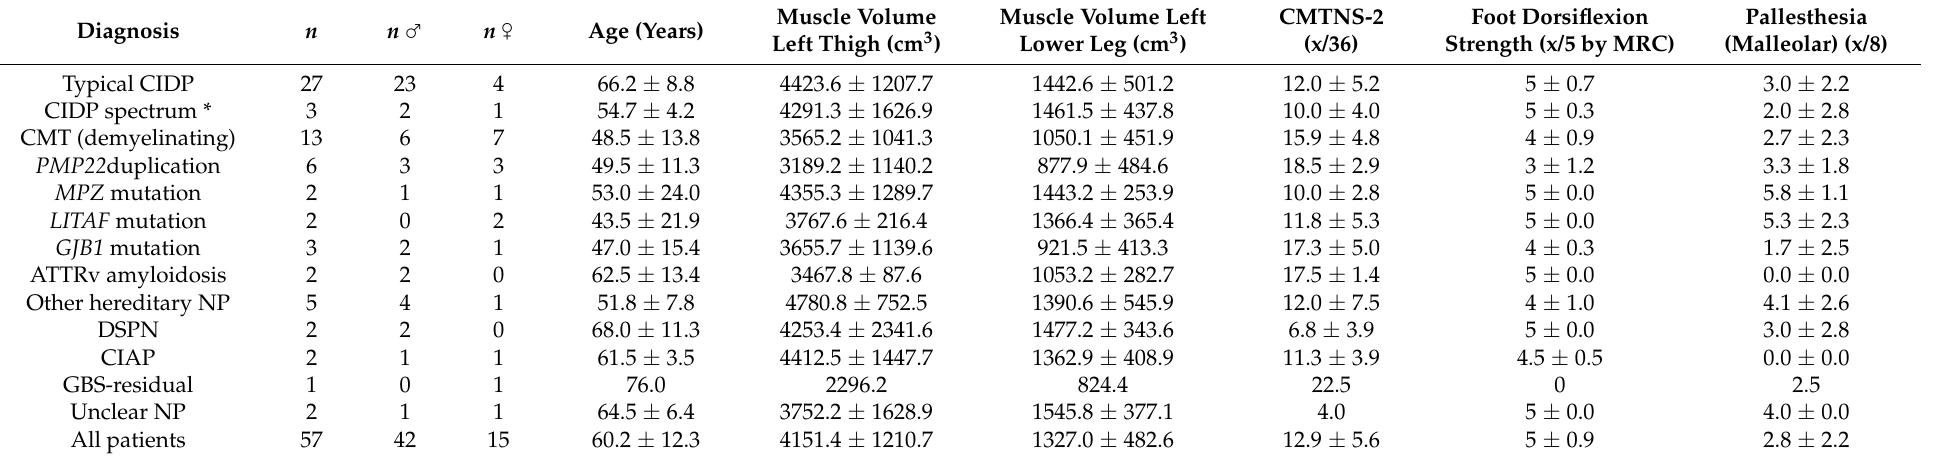
Table 1. Synopsis of the study population and